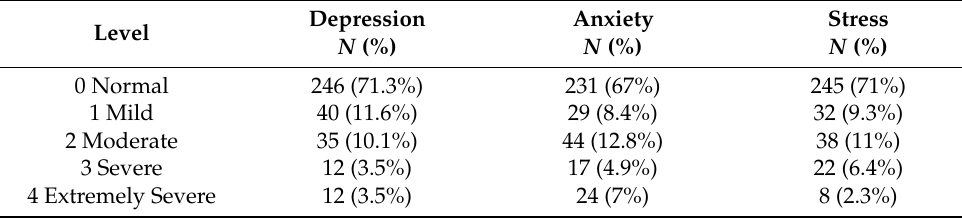
Table 2. Distribution of symptoms of depression, anxiety, and stress in the